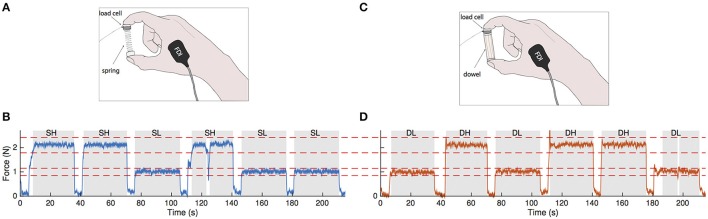
Visuomotor force tracking paradigm for a representative subject. (A) A small compliant spring is compressed between the index finger and thumb. Fingertip forces and bipolar surface EMG from the intrinsic hand muscles FDI and APB (not shown) were recorded. (B) Force tracking task showing three random presentations during spring compression at forces of 1.0 and 2.1 N. Each force level (high or low) was presented to the subject for 30 s with an inter-stimulus interval of 5 s. The blue trace represents the recorded compression force. Red dotted lines indicate the ±15% tolerance limits relative to target force. Data that are within the tolerance limits for a minimum of 5 s in duration (shaded regions) were used in the coherence analysis. In the fourth hold, the compression force briefly fell out of the tolerance range. (C) The visuomotor task is repeated with a stable wooden dowel. (D) Force tracking profile with the dowel at the same force levels and tolerance limits as with the spring. Gray areas represent data within tolerance and dowel-low and dowel-high refer to dowel-low and dowel-high, respectively.